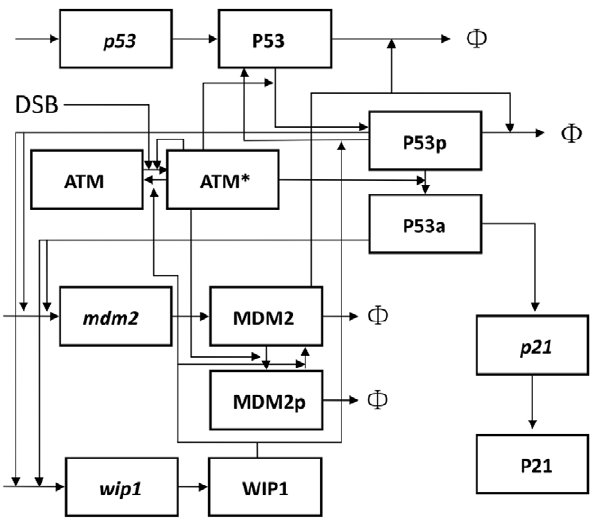
Figure 1. Schematic representation of p53 network. Italics represent mRNA species and W denotes degradation.